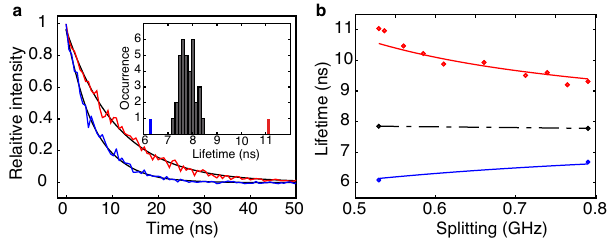
Fig. 3 Comparison of the subradiant and superradiant lifetimes. a Decays curves of the subradiant and superradiant states. The laser pulses have a rise-fall time of 1 ns and a repetition rate 100 kHz. The solid curves are exponential fi ts with lifetimes τ + = 6.3 ns and τ − = 11.1 ns, which are (cid:3) (cid:4) (cid:2) 1 ¼ (cid:2) 2 ab γ consistent with the computed subradiant lifetime τ (cid:2) ¼ γ (cid:3) (cid:4) 0 12 (cid:2) 1 ¼ 0 : 77 γ (cid:2) 1 1 : 43 γ (cid:2) 1 and the superradiant one τ þ ¼ γ þ 2 ab γ , using a 0 0 0 12 = 0.88, b = 0.47, γ = 0.35 γ fi cients a and b are deduced from 12 0 . The coef the diagonalization of the Hamiltonian H in the absence of laser fi eld. The detuning Δ = 15 γ 0 is derived from the splitting between |A 〉 and |S 〉 and from the coupling constant V = 9.5 γ 0 that is deduced from the fi ts of the excitation spectra at various excitation intensities. Inset: Histogram of the lifetime of 35 uncoupled single molecules. The blue and red bars indicate the values of τ + and τ − for the coupled pair. b Evolution of τ + (blue circles) and τ − (red circles) with the molecular detuning Δ which is varied by differential Stark shifts of the molecular resonances from 15 γ 0 to 32 γ 0 . The solid curves are the computed values of τ + and τ − . The black circles are the inverse of the average subradiant and superradiant decay rates ( τ (cid:2) 1 and þ τ (cid:2) 1 ), and coincide with the average lifetime of the uncoupled single (cid:2) molecules (black dashed